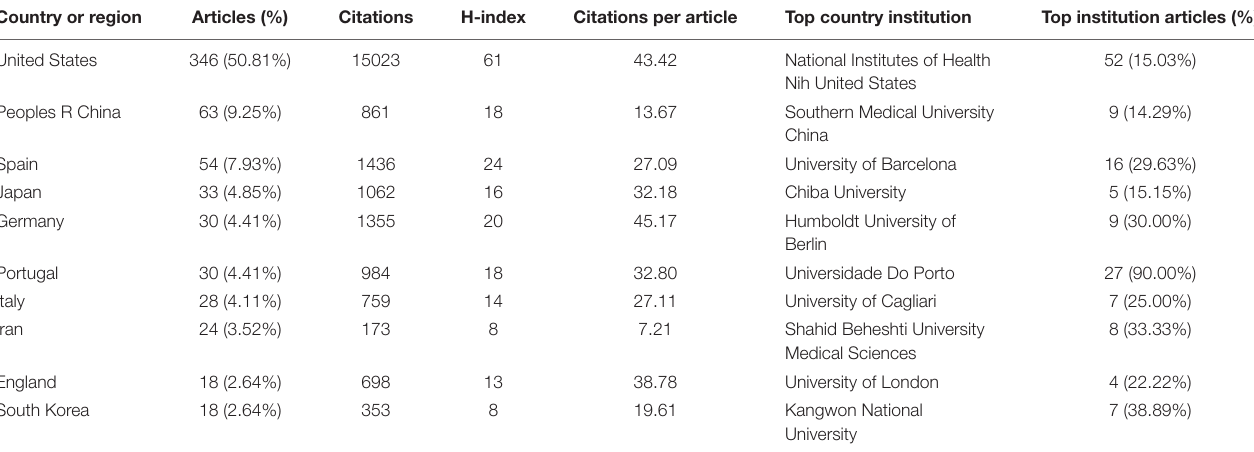
TABLE 1 | The top 10 productive countries and